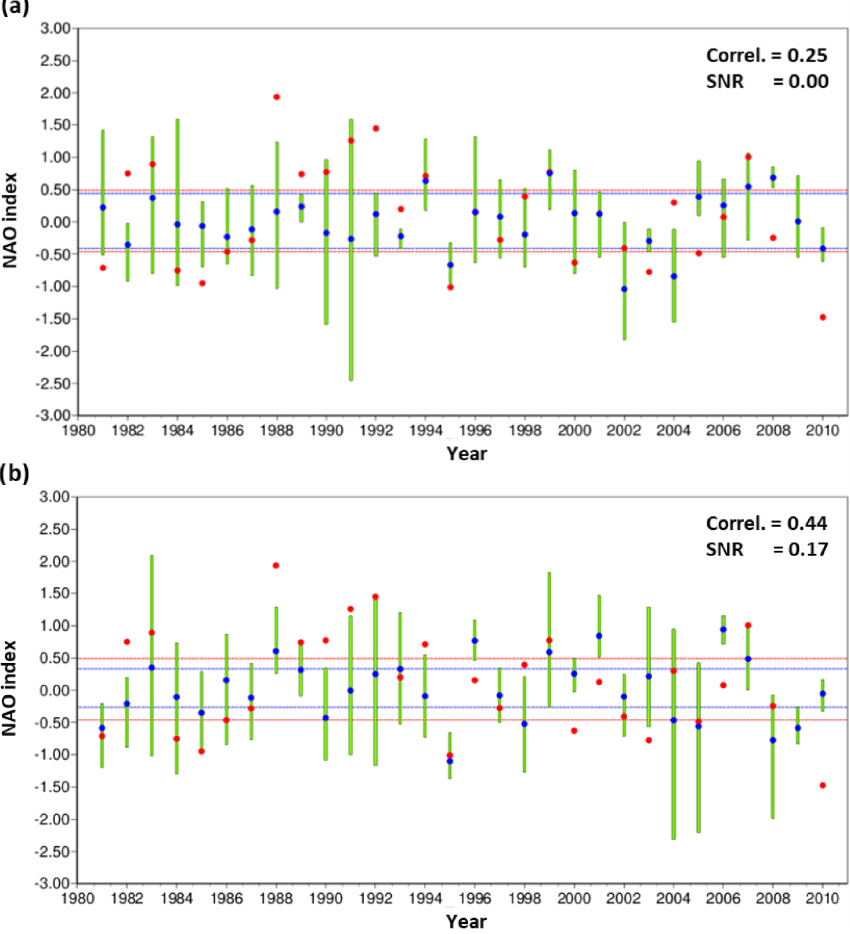
Figure 16. Time series of the winter (DJF) NAO index for the long-range experiment using (a) the default configuration and (b) the experiment using the new BMS ozone, together with NAO index values from the ERA-Interim reanalysis. Red dots represent the NAO index value from ERA-Interim reanalysis, and blue dots correspond to the ensemble mean of the model runs; the green bars show the ensemble variability for each year NAO index. The NAO index is calculated as the first empirical orthogonal function (EOF) of the geopotential height Z500 over the North Atlantic sector. The correlation value between the ensemble mean NAO index and the reanalysis NAO index time series is also included in each panel, together with the signal-to-noise ratio (SNR) value for each case. The horizontal lines delimit the main tercile interval for the ensemble mean time series of the model experiments (blue) and ERA-Interim